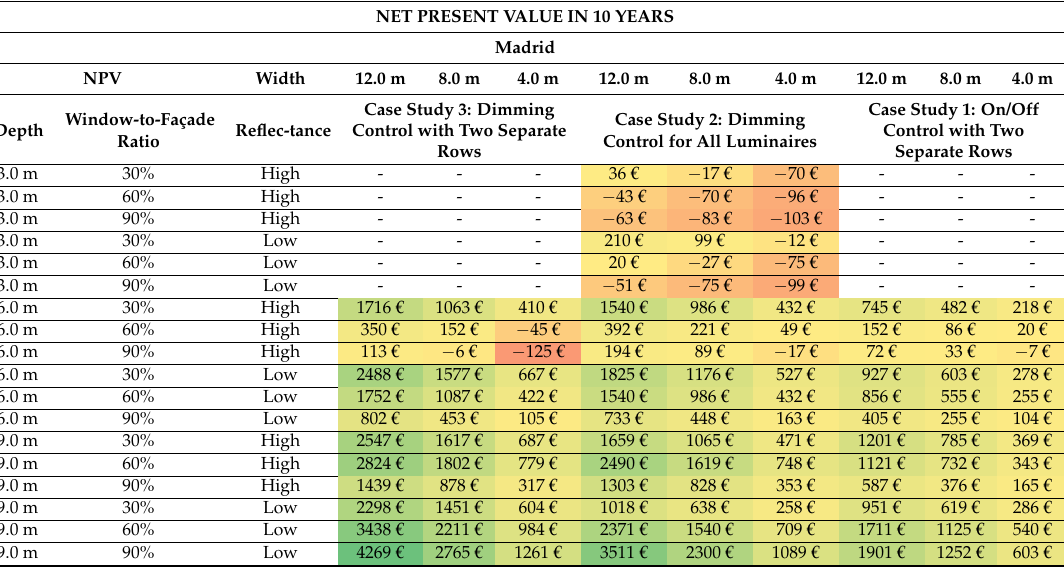
Table 17. Net present value in 10 years according to different lighting smart controls in Madrid. NET PRESENT VALUE IN 10